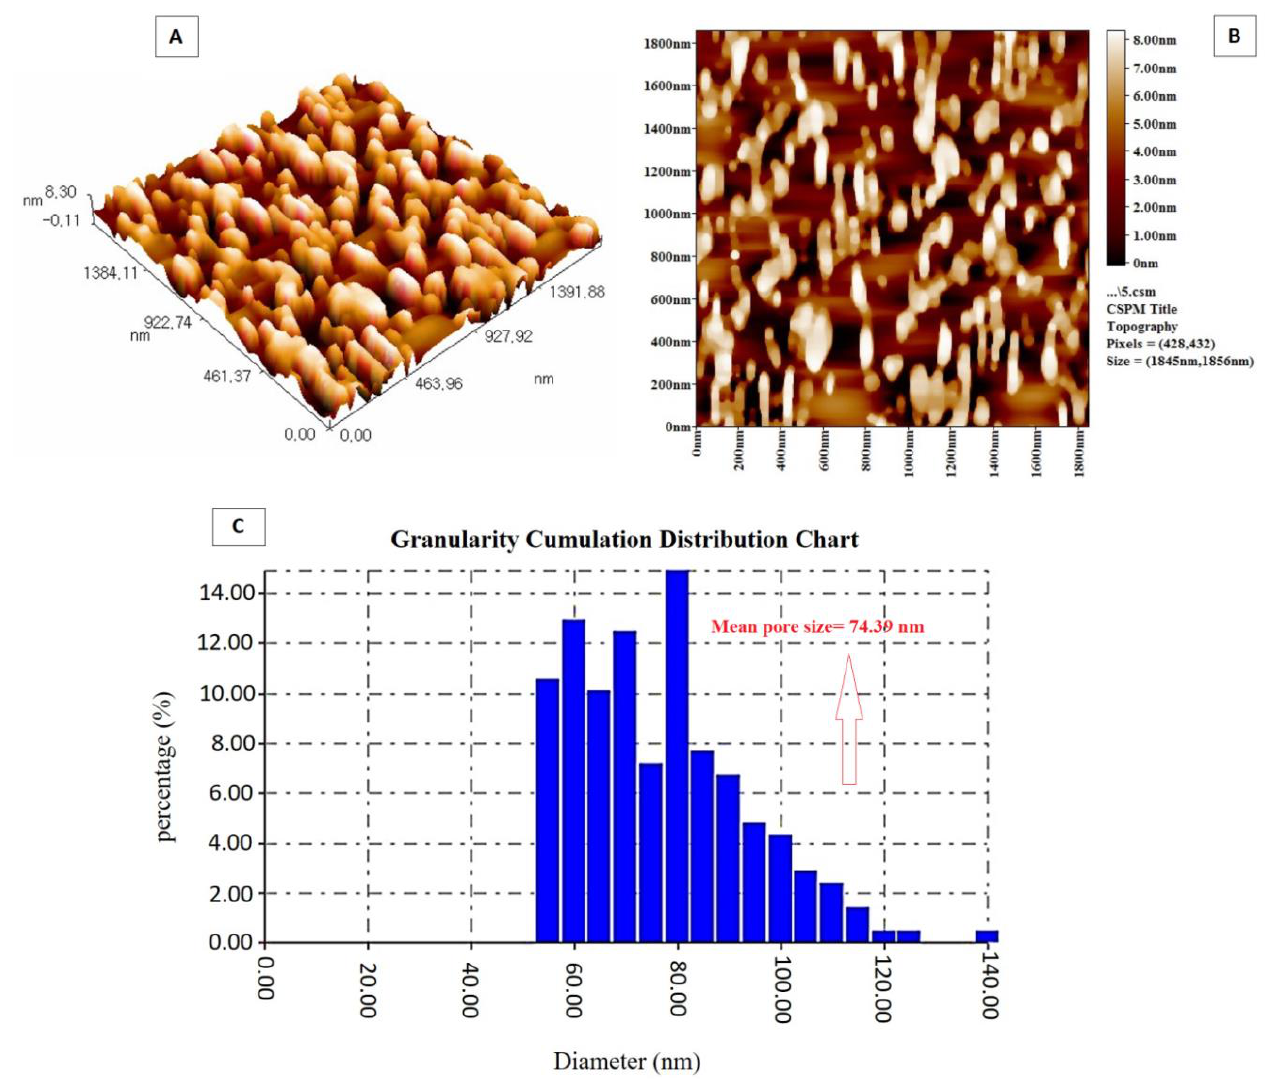
Figure 2. ( A ) Three − dimensional (3D) AFM image of PTGM graft co-polymer. ( B ) Two − dimensional (2D) AFM image of PTGM graft co-polymer. ( C ) Mean particle size and particle size distribution of PTGM graft co-polymer.